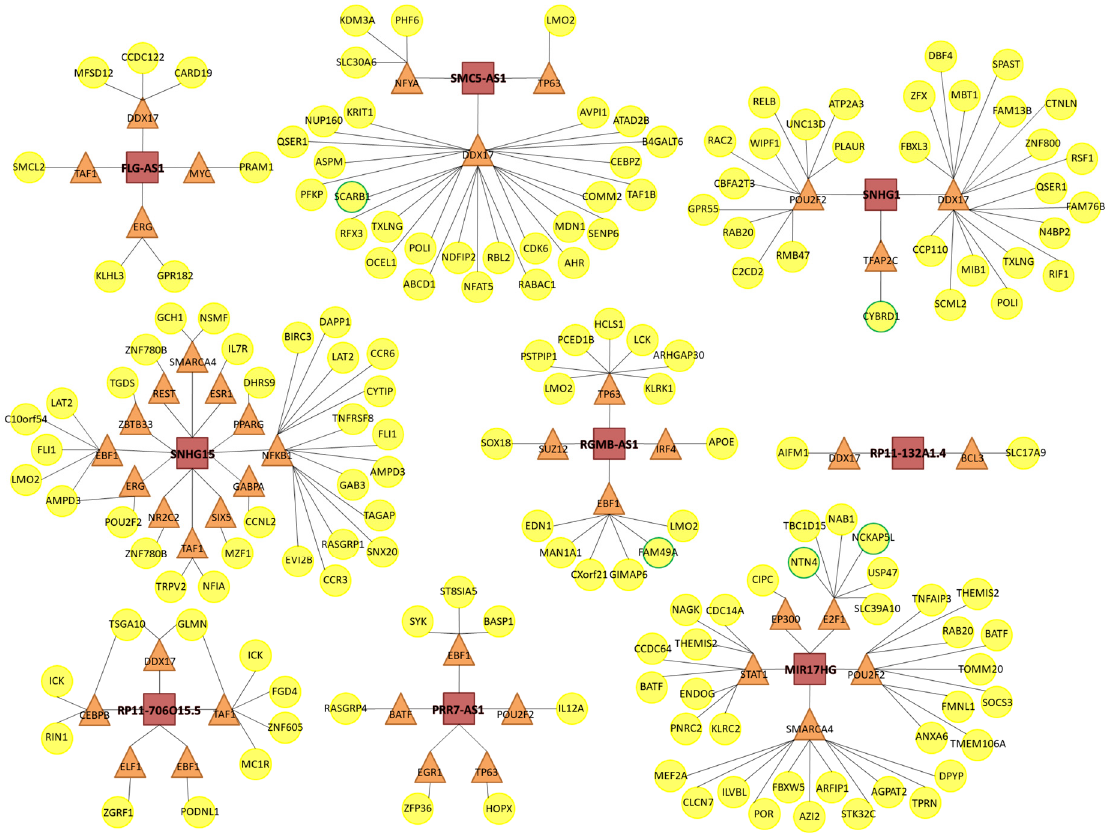
Figure 7. Predicted lncRNA-mediated transcription perturbations in response to olaparib. Diagrams illustrating data from the lncMAP database with regard to olaparib-modulated lncRNA-transcription factor-gene triplets in the skin cutaneous melanoma (SCKM) TCGA cohort. Olaparib-modulated lncRNAs are shown as red squares. Transcription factors are shown as orange triangles. Target genes are shown as yellow circles. Genes highlighted in green suffered a significant change in gene expression after olaparib treatment in our model.